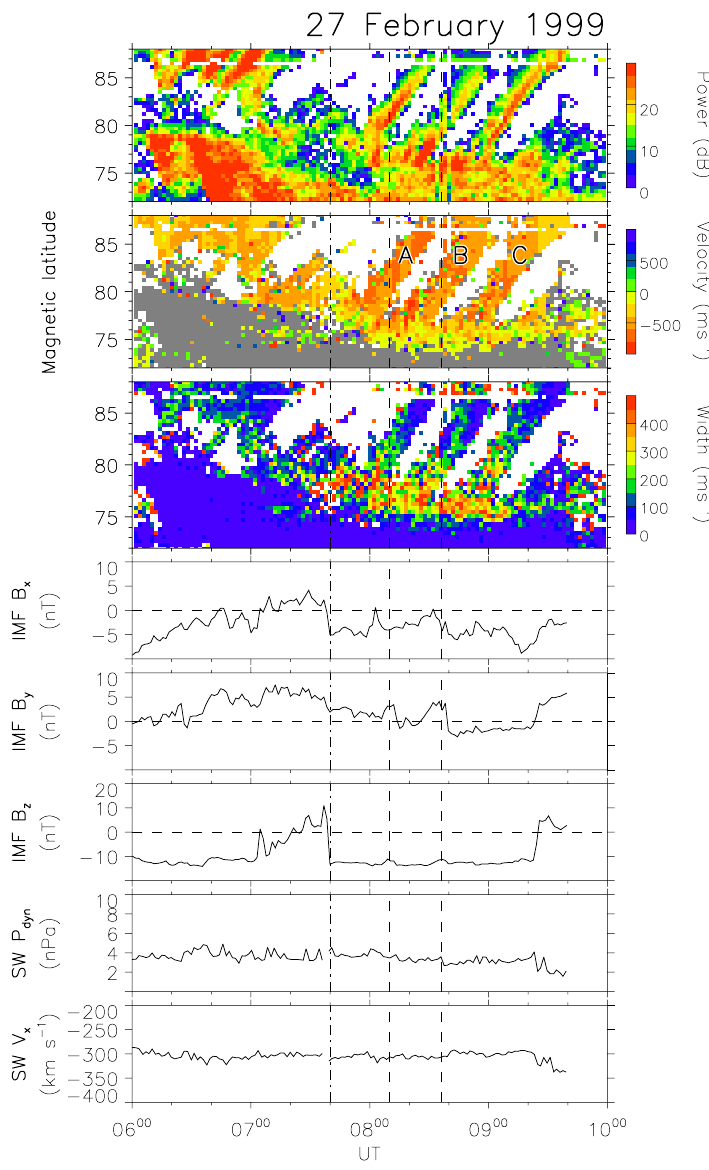
Fig. 2. The top three panels present latitude-time plots of backscatter power, line-of-sight plasma drift, and spectral width as measured by the radar. Three polar patches are indicated by the letters A, B, and C. The bottom five panels present the B X , B Y , and B Z components of the IMF, and solar wind dynamic pressure and velocity, time-shifted for the expected solar wind propagation delay between the Wind spacecraft and the arrival of these features at the subsolar